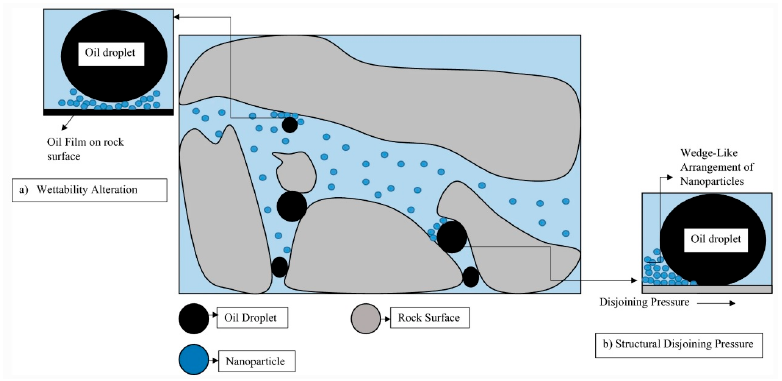
Figure 2. Mechanism of NPs EOR. ( a ) Changing wettability and ( b ) structural pressure by NPs [31].